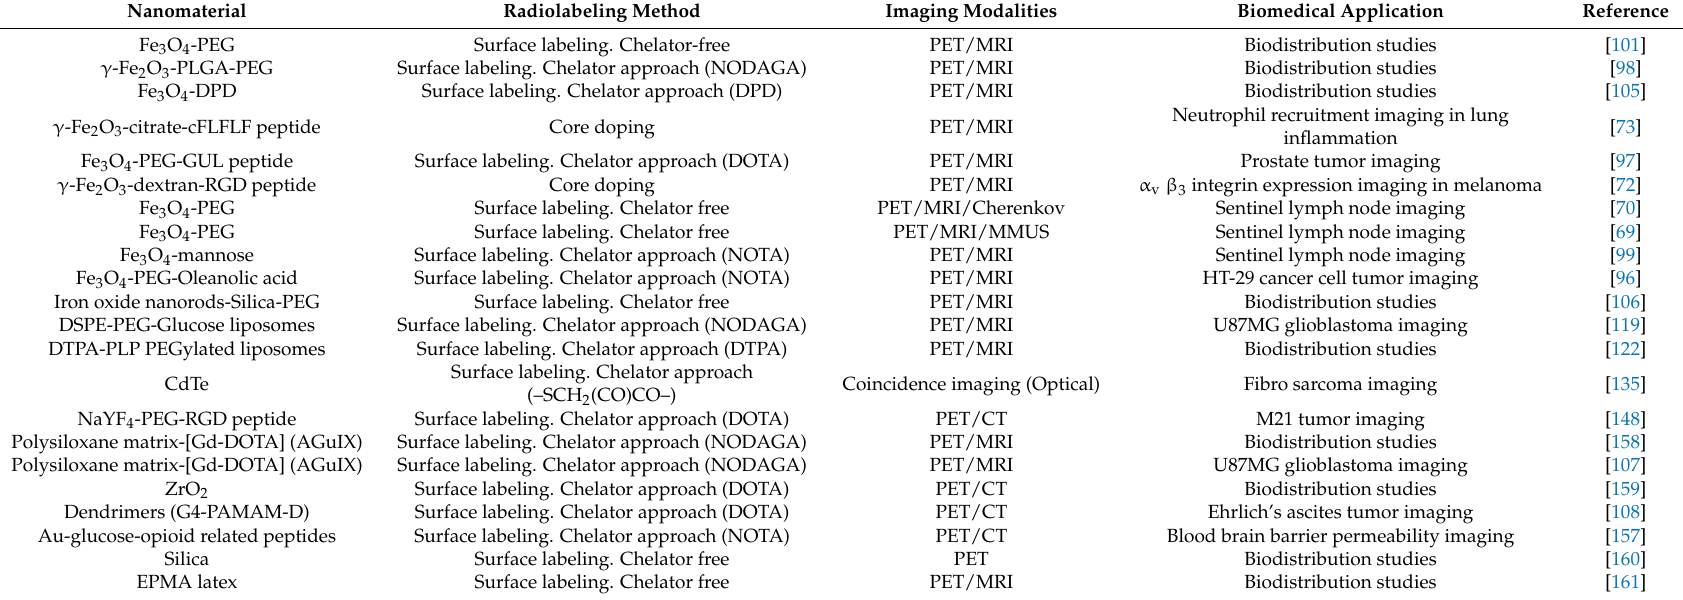
Table 2. Examples of the combined use of nanomaterials and 68 Ga. MRI: magnetic resonance imaging; MMUS: magnetomotive ultrasound; CT: computed